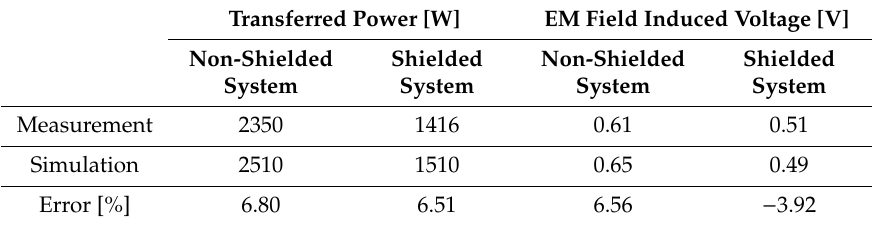
Table 5. Maximal relative error of the proposed models in given frequency range.